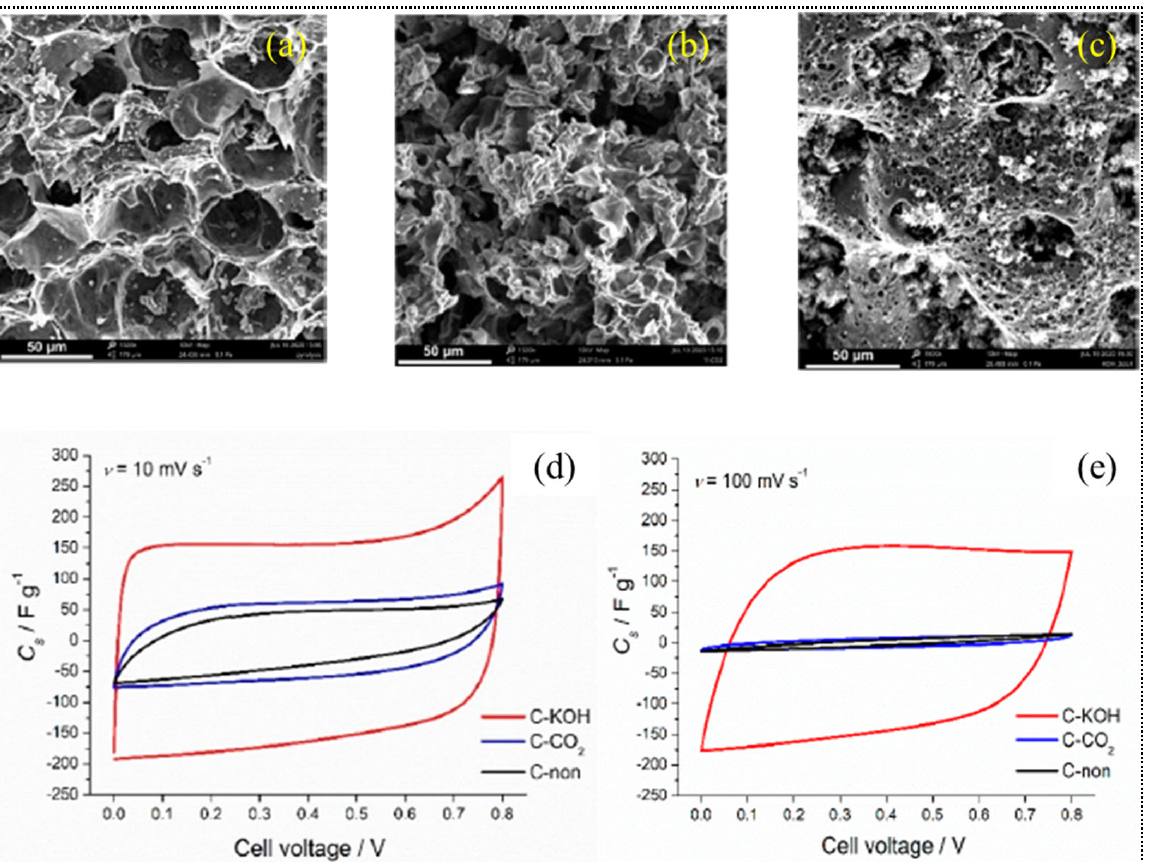
Figure 8. SEM Images of: ( a ) non activated, ( b ) physical activated carbon, ( c ) chemically activated carbon, ( d ) cyclic voltammetry curves at 10 mVs − 1 ( e ) at 100 mVs − 1 . Reprinted with permission from Ref. [76]. Copyright © 2020 MDPI.